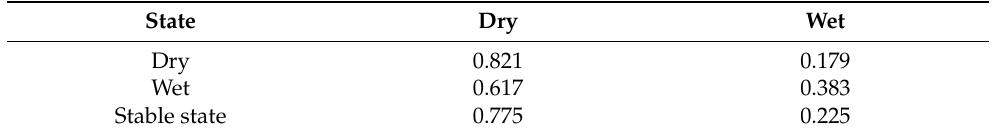
Table 1. Probability and Stable State Matrices for the Navasota River Bridge Site, Texas, U.S. (33 ◦ 14 (cid:48)